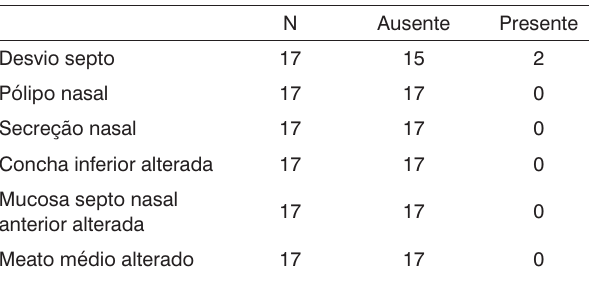
Tabela 4. Resultados encontrados na Nasofibroscopia (NF).